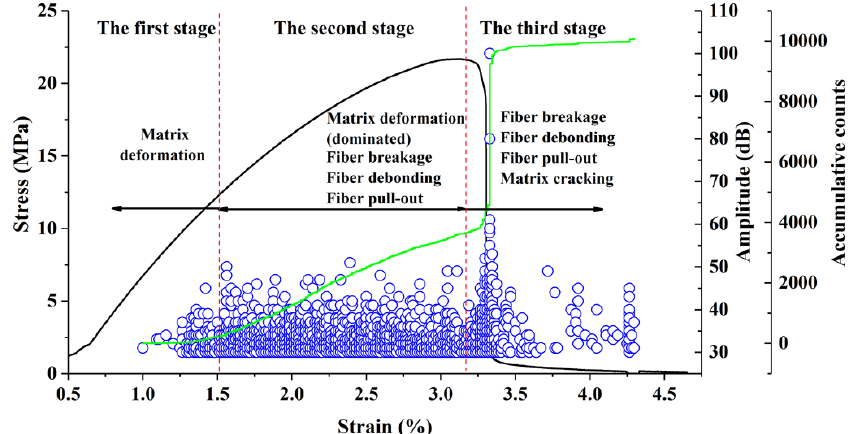
Figure 5. Distribution of damage and fracture stage and mode. The black curve represents stress-strain curve; the green curve represents AE accumulative counts; and the blue circle represents amplitude.